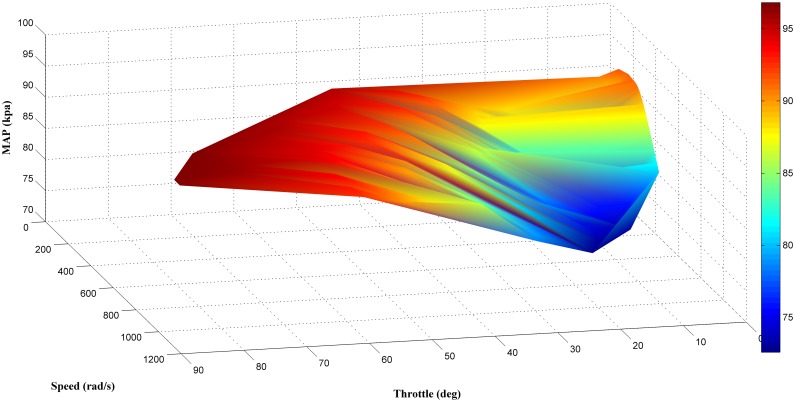
3D Surface plot of the trained estimator (LM+BR+PSOb).